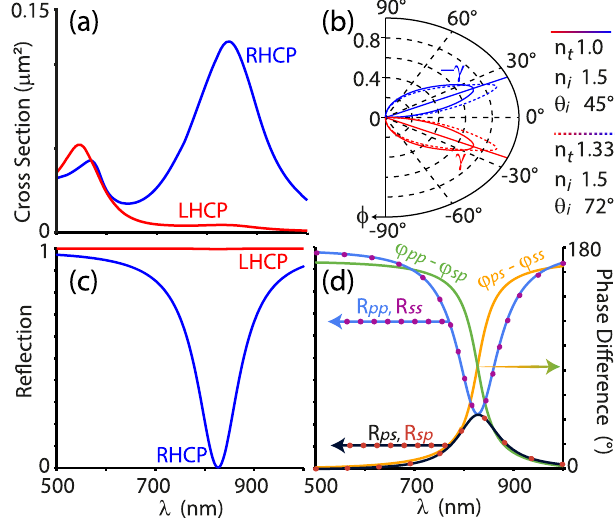
FIG. 4. Origin of the spin selectivity. (a) Finite elements method calculation of the extinction cross section of a single elongated gold nanoparticle, when illuminated at θ i ¼ 45 ° and ϕ ¼ 25 °. (b) The excitation contrast γ , see Eq. (4), for a glass-air and glass-water interface. (c) Calculated RHCP and LHCP reflection spectra with optimized ρα for the glass-water configu- ration in (b), showing 99% spin selectivity. (d) Reflection matrix components with the same parameters as